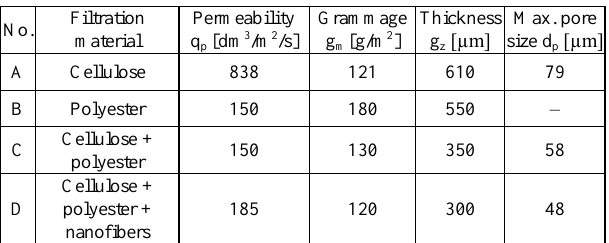
Table 1. Tested filtration materials parameters according to the manufac- turer's data [12] No.